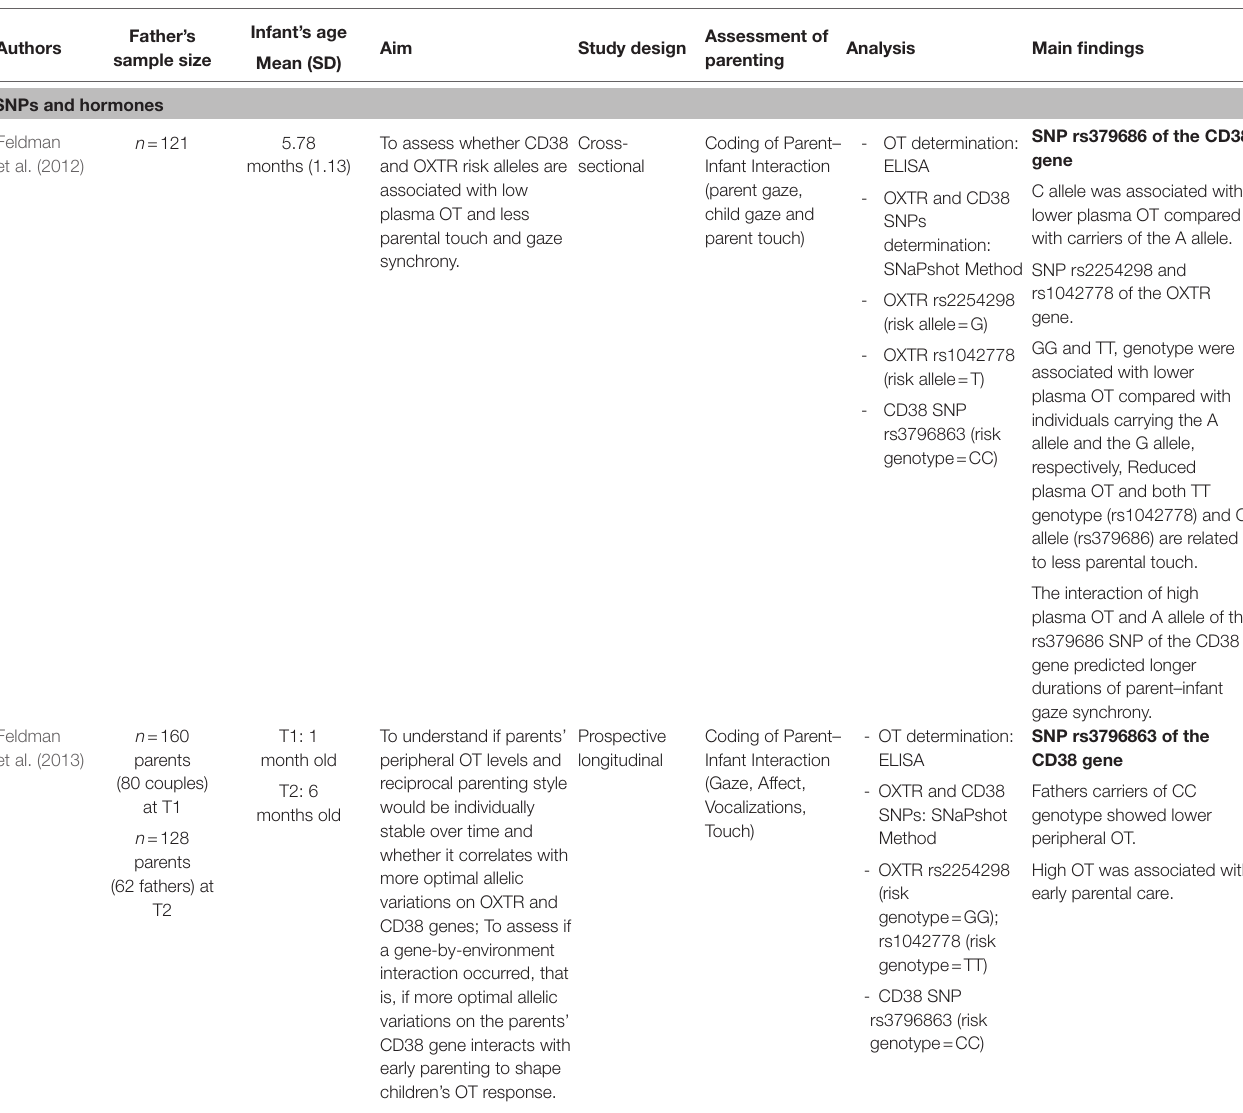
TABLE 1 | Main characteristics and findings of the